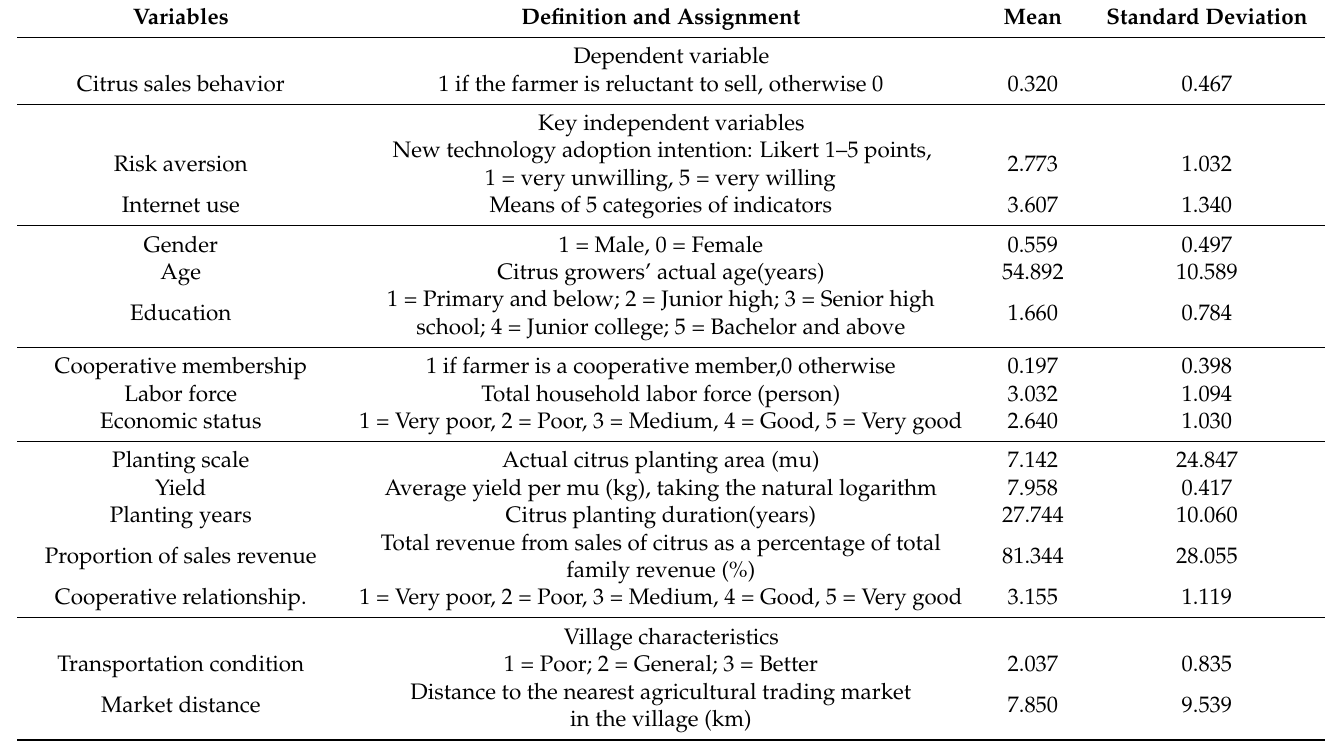
Table 2. Variable definitions and descriptive